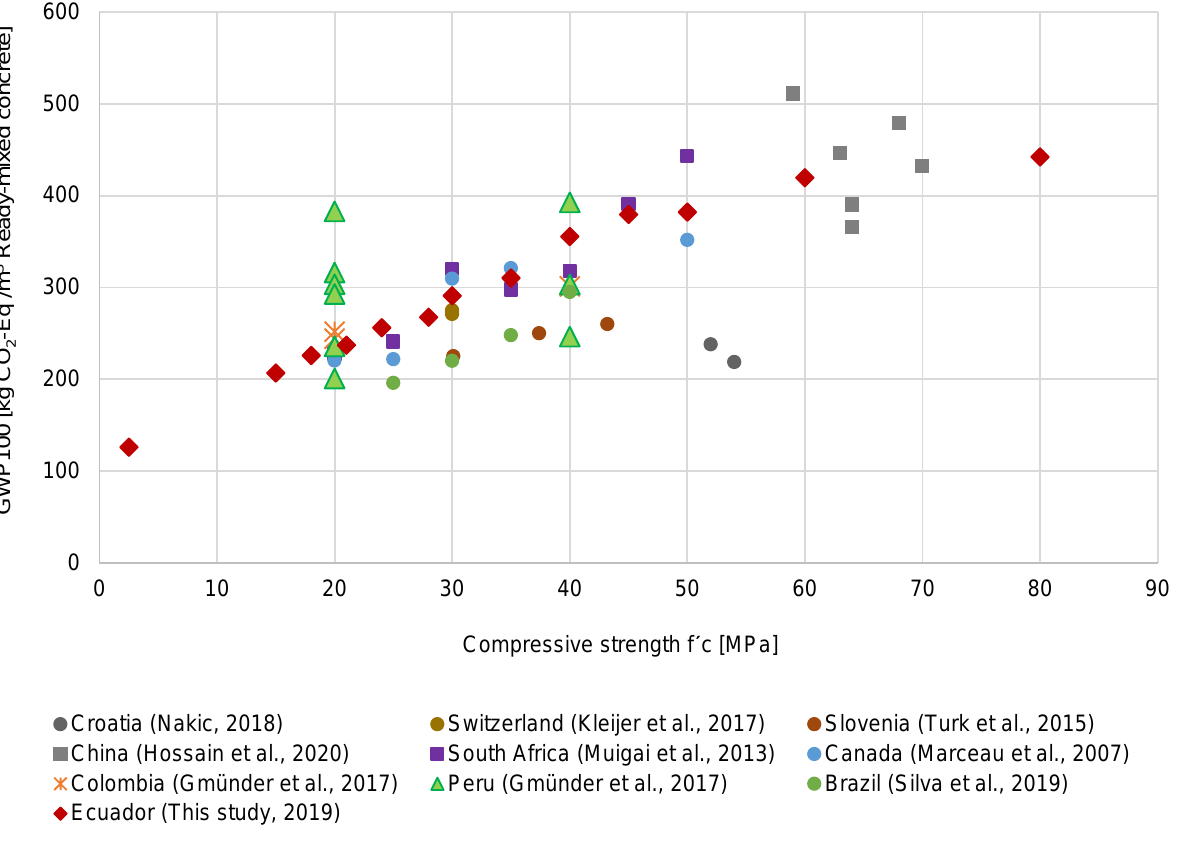
Figure 5. Global warming potential results of ready-mixed concrete in literature reviewed and this study. 457 For the compressive strength of 30 MPa, this study reports a value of 290.85 kg CO 2 - 458 Eq/m 3 of ready-mixed concrete. The results of Canada and South Africa are 6.44 and 9.91% 459 higher, respectively. This study has a result of 310.30 kg CO 2 -Eq/m 3 for 35 MPa ready- 460 mixed concrete. This result is within the range of 297.56 to 320.97 kg CO 2 -Eq/m 3 of ready- 461 mixed concrete for Canada and South Africa [51,52]. The study for Slovenia presents val- 462 ues below the average of the rest of the countries due to the use of steel slags and foundry 463 sands [49], in particular, 22.64 and 19.43% lower compared to the results for 30 and 35